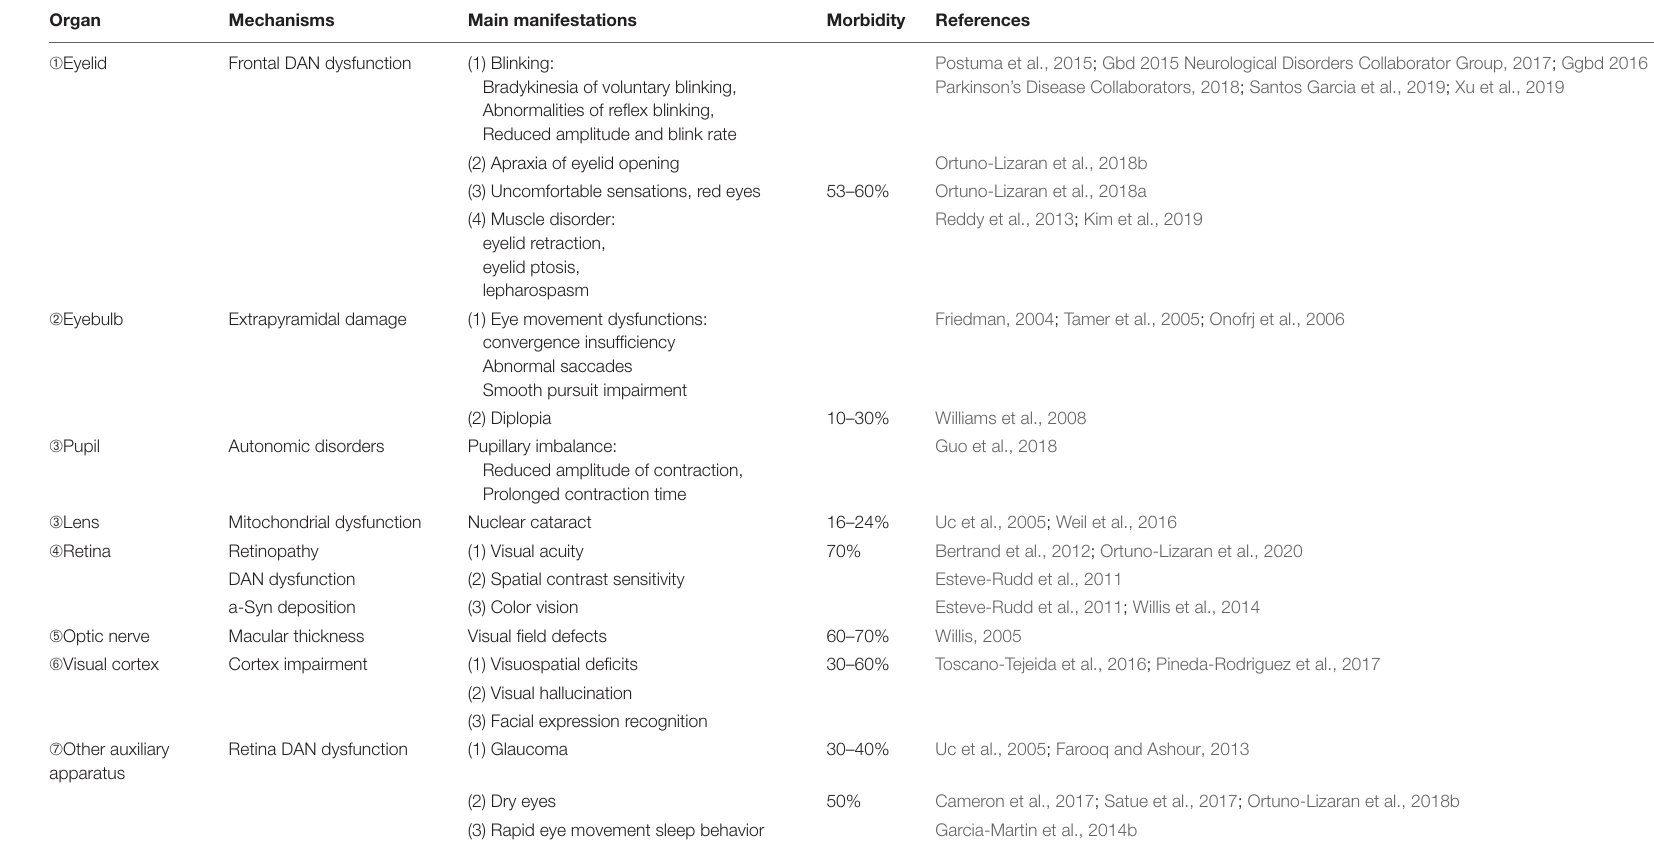
TABLE 1 | Visual dysfunctions and manifestation in PD